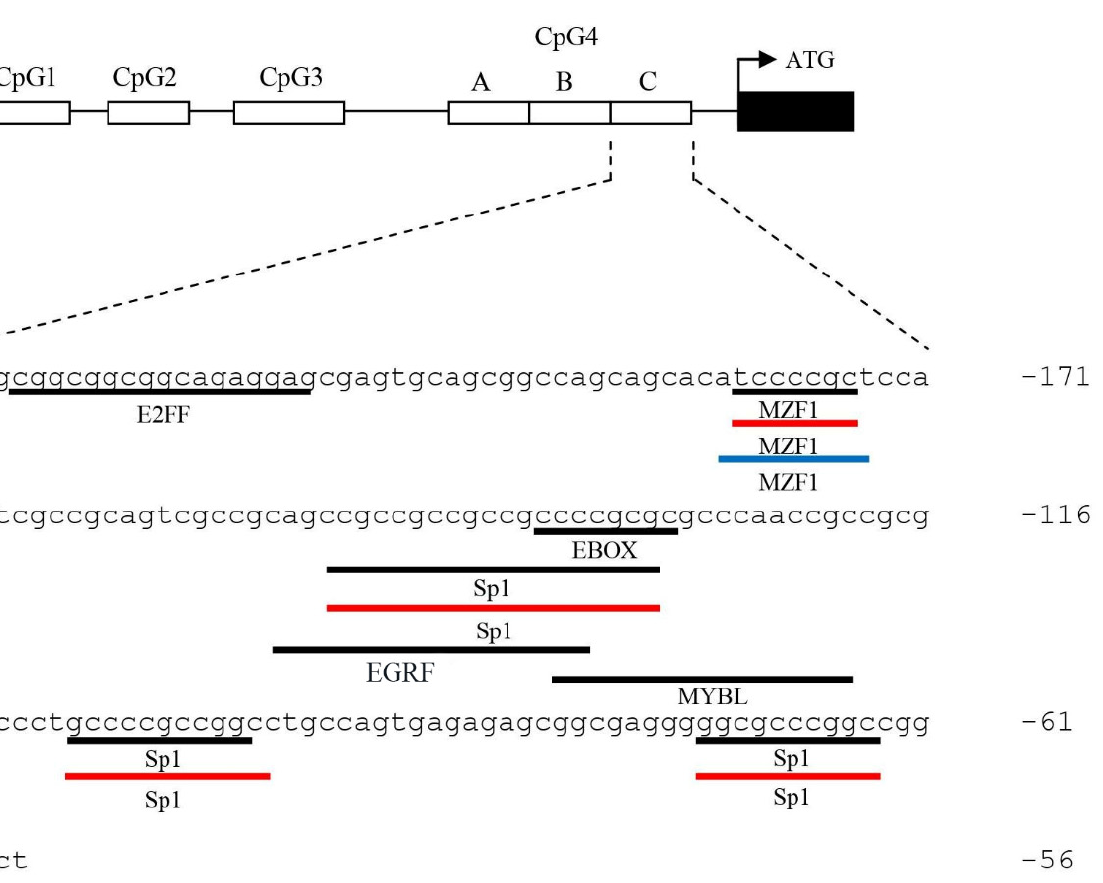
Figure 4. The transcription factor binding elements (underlined sequence) predicted within CpG island 4C of ck α promoter using MatInspector (black underline), Alggen PROMO (red underline) and DRAF omicX (blue underline). The numbers shown on the right panel indicate the number of bases from ATG translation start site.